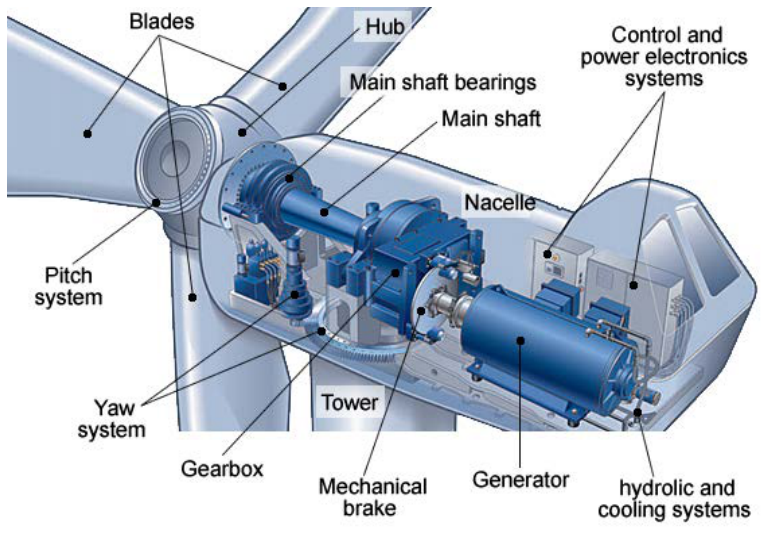
Figure 8. Typical main components of a utility-scale